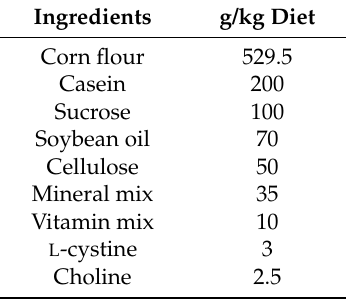
Table 3. Ingredients of basal